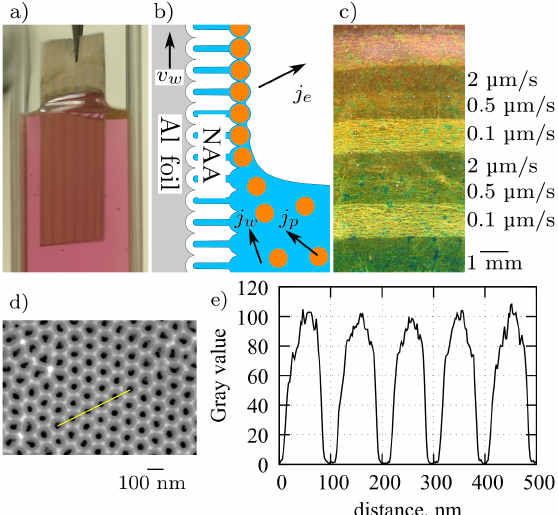
Figure 1. ( a ) Photograph of a NAA coated aluminum sheet during withdrawal from Au nanoparticle colloid. ( b ) Diagram of the convective nanoparticle assembly on a NAA surface. ( c ) Dark-field photograph of 80 nm Au NPAs on an Al-NAA substrate obtained by dip-coating with different withdrawal speeds. ( d ) Top view SEM image of NAA and ( e ) corresponding line profile from a region